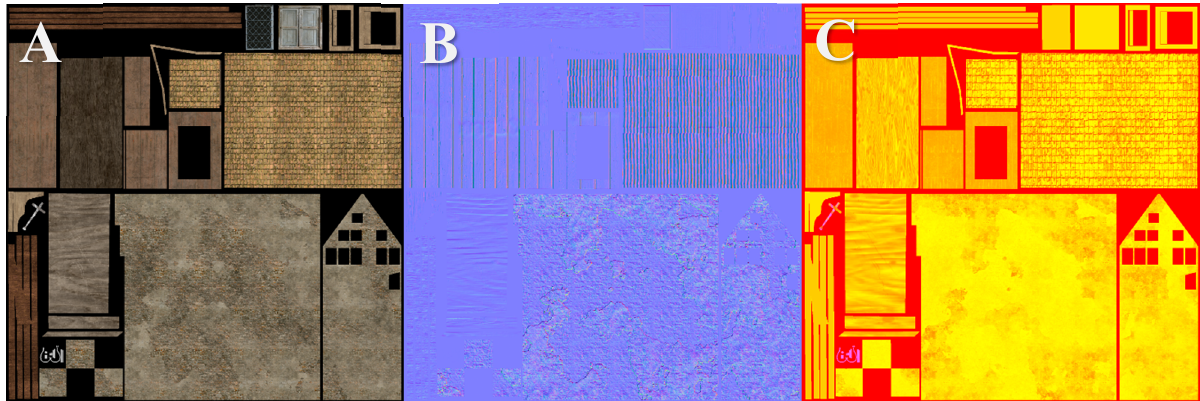
Figure 7. Texture atlases for one townhouse. (A) Diffuse maps; (B) Normal maps; (C) Roughness, ambient occlusion, and metallic maps.